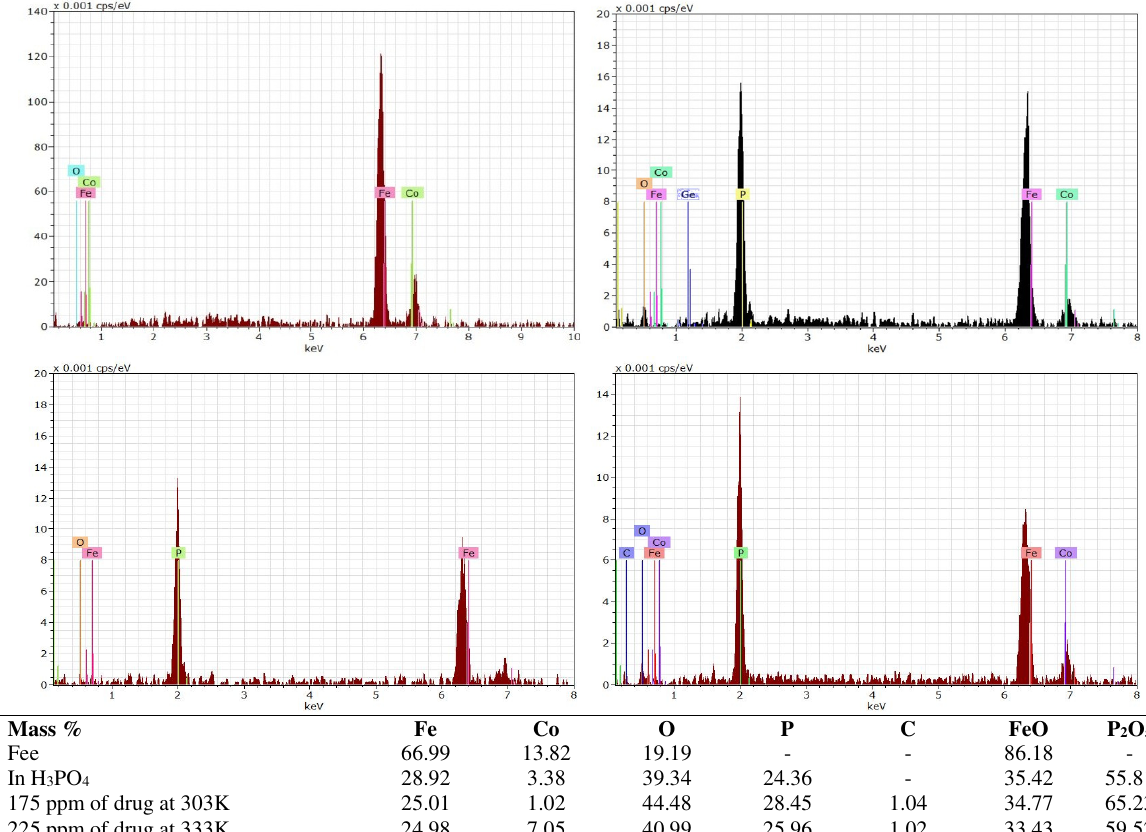
Fig. 6. EDX analysis of (a) polished, (b) corroded, (c) inhibited sample at 303K and (d) inhibited sample at 333K.